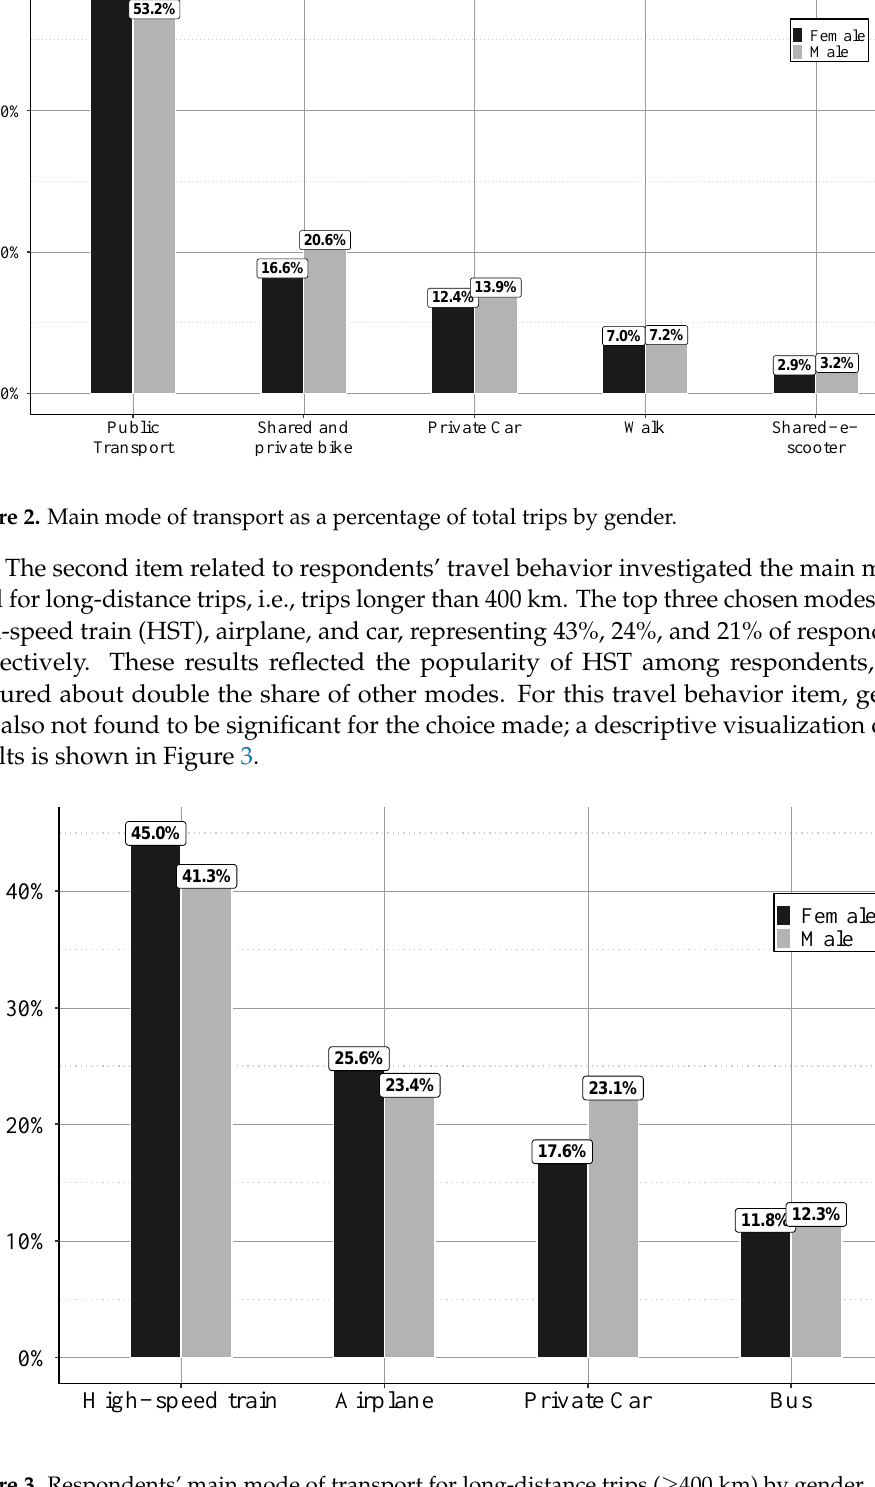
Figure 3. Respondents’ main mode of transport for long-distance trips ( ≥ 400 km) by gender. Users also had to specify their use frequency for bus, car, airplane, HST, and ride– sharing services such as (BlablaCar). The frequency of use was specified on a four-point